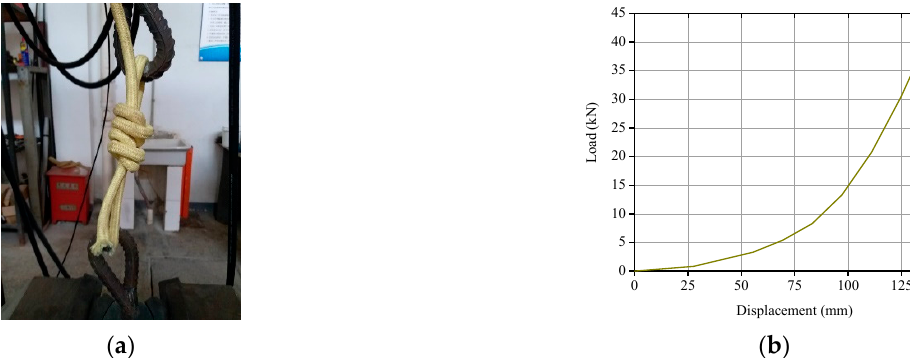
Figure 4. Knot test for binding CFR: ( a ) Picture of knot test site; ( b ) Load-displacement curve of knot test.